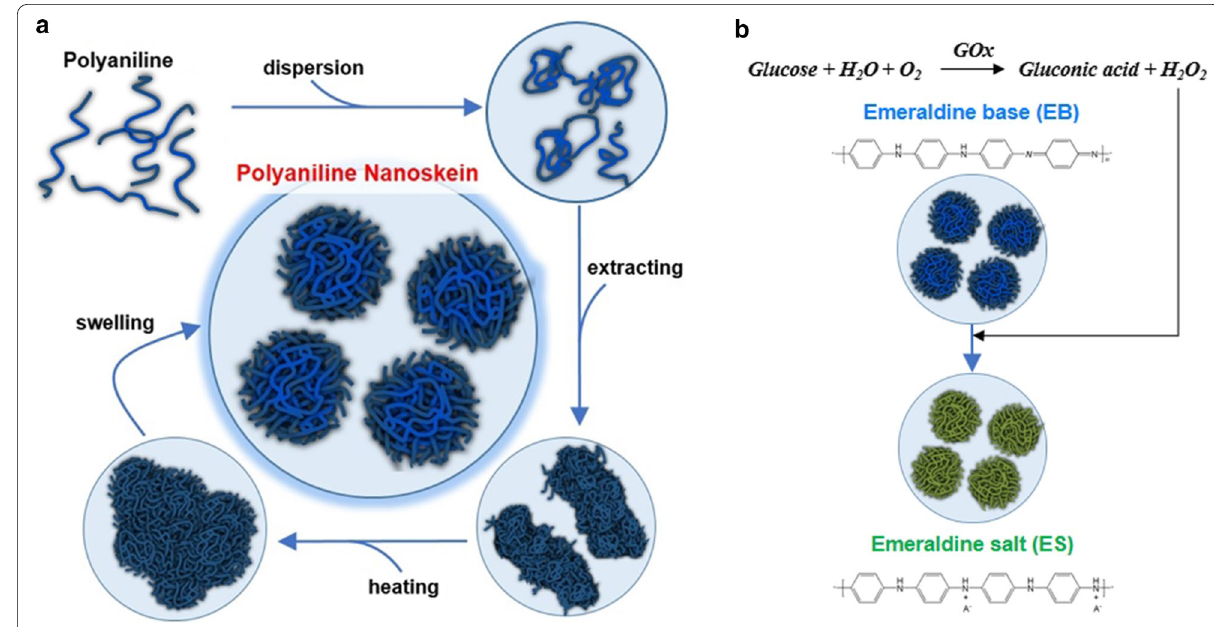
Fig. 1 a The synthetic process of polyaniline nanoskein (PANS). b Glucose sensing process using